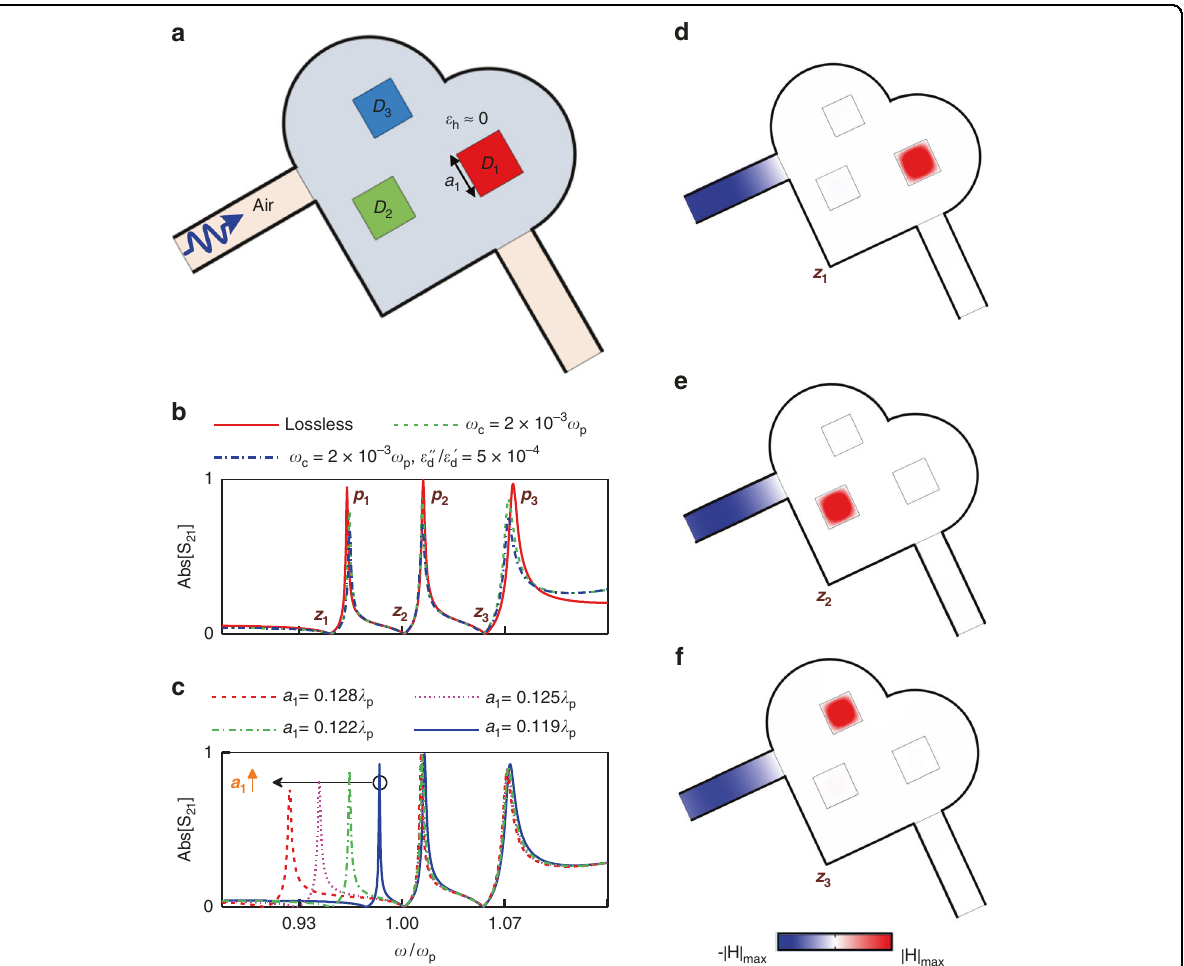
Fig. 3 Tunable response and fi eld con fi guration analysis. a Con fi guration of a 2D ENZ host containing three dopants with square cross sections, which is connected by two air- fi lled waveguides. The cross-sectional area of the ENZ host is 0.33 λ p2 ( λ p is the free-space wavelength at ω p = 2 π × 3 × 10 9 rad/s), while three square dopants D 1 , D 2 , and D 3 are chosen with the permittivity ε d = 37 and side lengths of 0.122 λ p , 0.116 λ p , and 0.11 λ p , respectively. b Simulation results for the transmission amplitude spectrum for lossless and lossy cases. c Simulation results for the transmission amplitude spectrum for side length of the dopant D 1 changing from 0.119 λ p to 0.128 λ p with different values. The snapshots of the magnetic fi eld distribution for the zeros of transmission z 1 , z 2 , and z 3 are respectively shown in ( d ), ( e ), and ( f